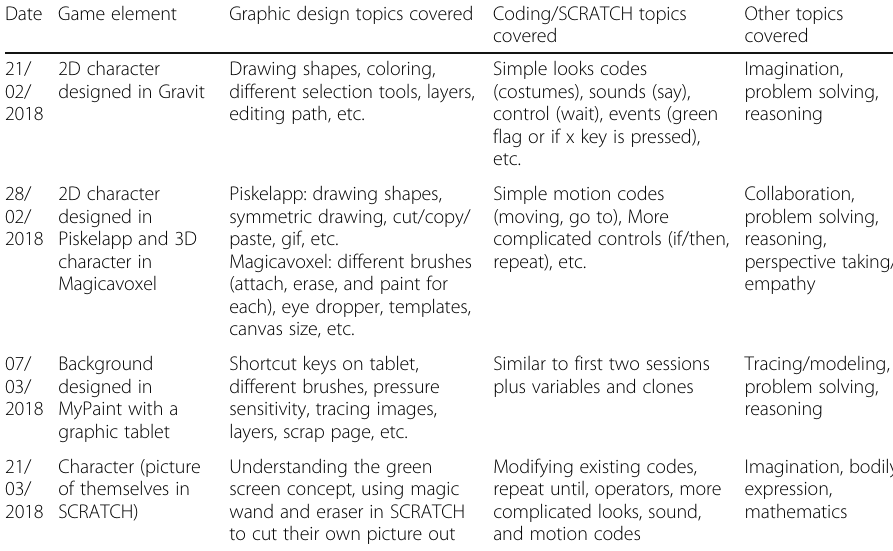
Table 1 Participant ’ s Overall Final Course Layout Date Game